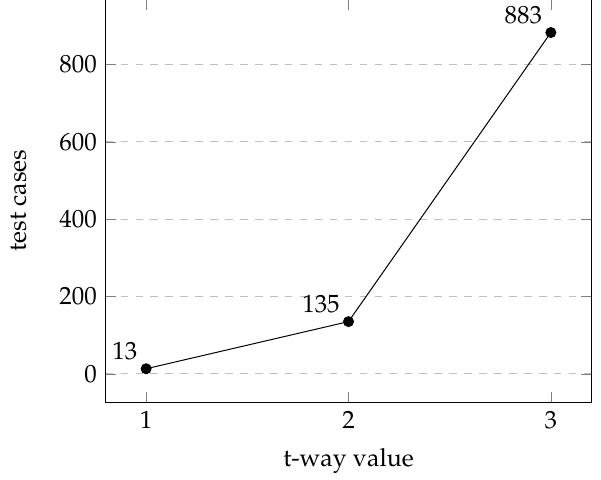
Figure 8. The number of generated test cases for various t -way options.